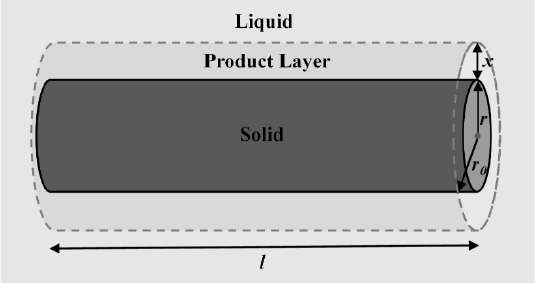
Figure 12. Schematic representation of the leaching of a cylindrical particle in bulk ( r 0 , the original radius of the particle; r, the radius of the particle after reacting for time t ; x, the distance that the solid-liquid interface moves inwards; l, the length of the particle).